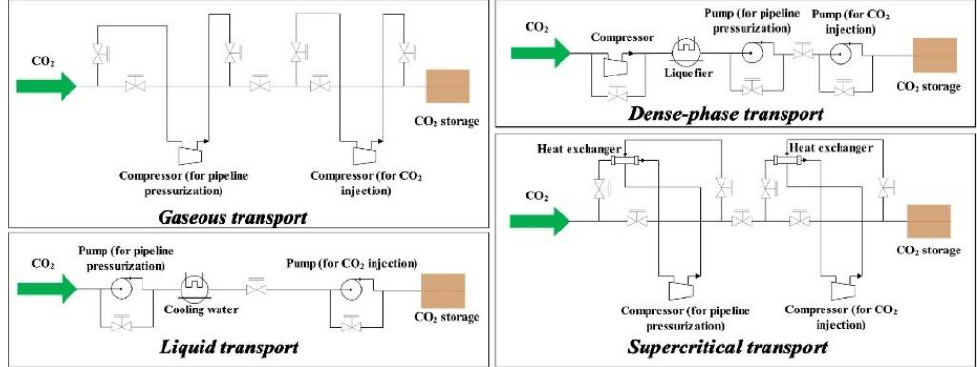
Figure 8. Four process flow charts applicable to large-scale CO 2 pipeline transportation. Reproduced with permission from [101], Elsevier, 2020.